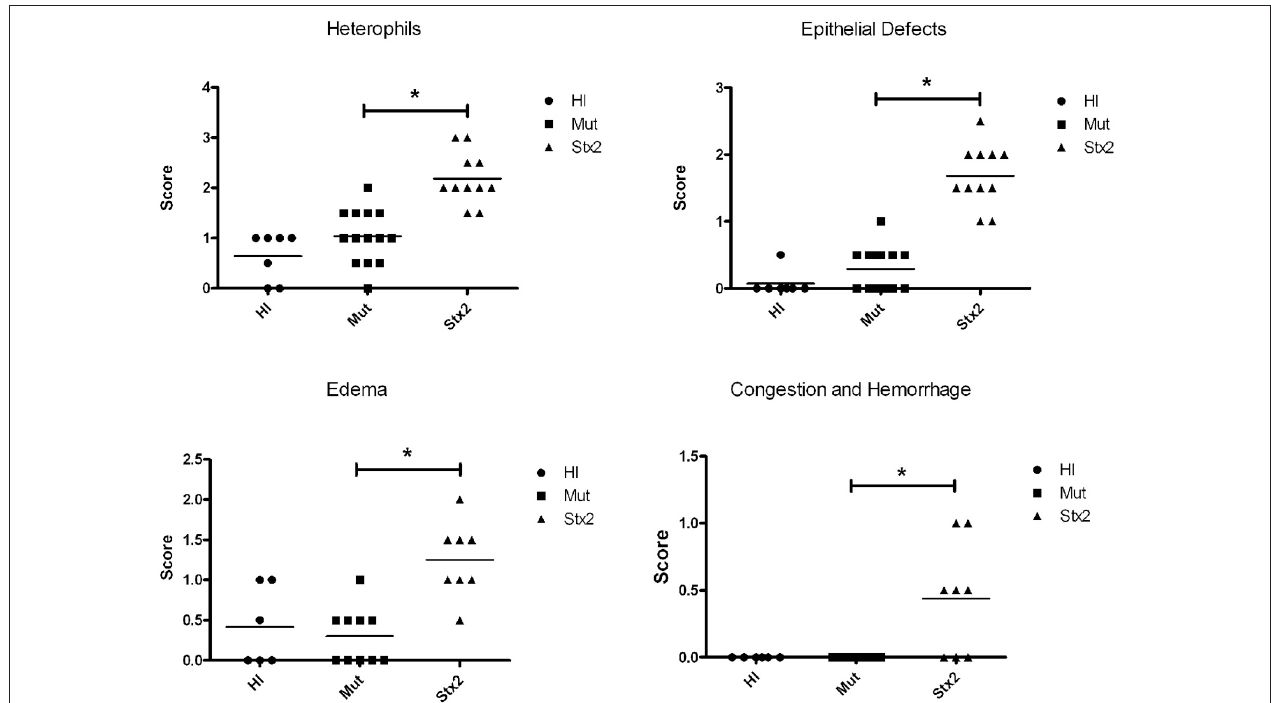
FIGURE 2 | Five litters composed of 32 animals were treated once a day for 2 days with 100 µ g/kg of heat-inactivated Stx2 (HI) ( n = 7), Stx2A E167QY77S B (Mut) ( n = 14), or Stx2 ( n = 11). Blinded scoring was performed for heterophil infiltration and epithelial defects. Similarly,